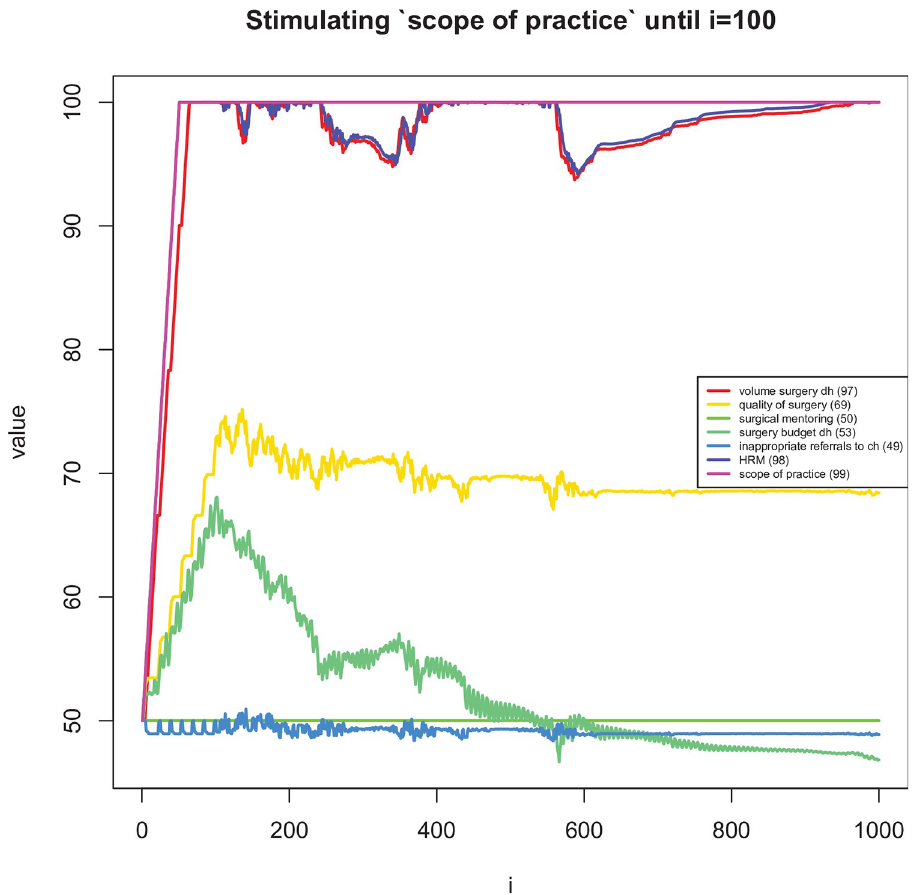
Fig 10. Long term dynamic explorations of the effects on changes in ‘scope of practice’ for the first 100 time periods.